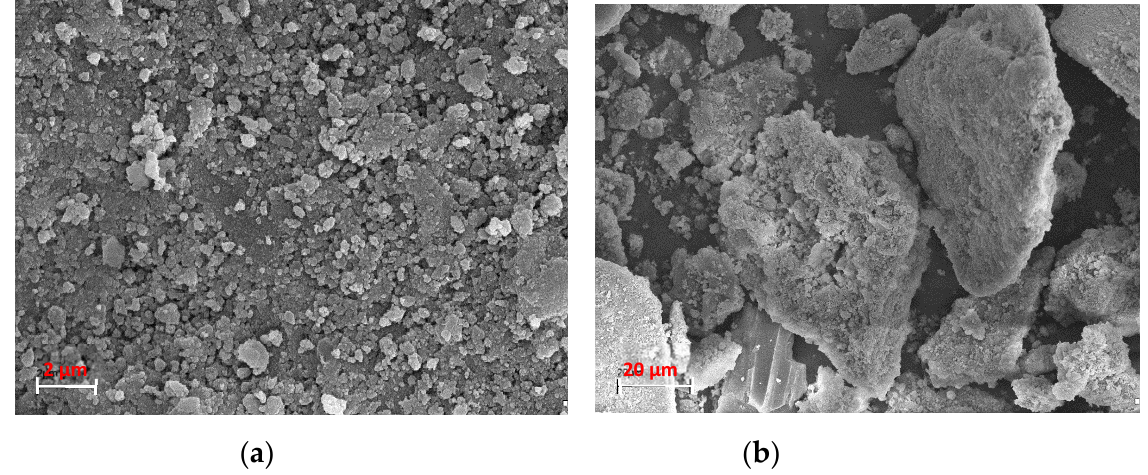
Figure 5. SEM images of SS-FA, scale bar: ( a ) 2 μ m, ( b ) 20 μ m.